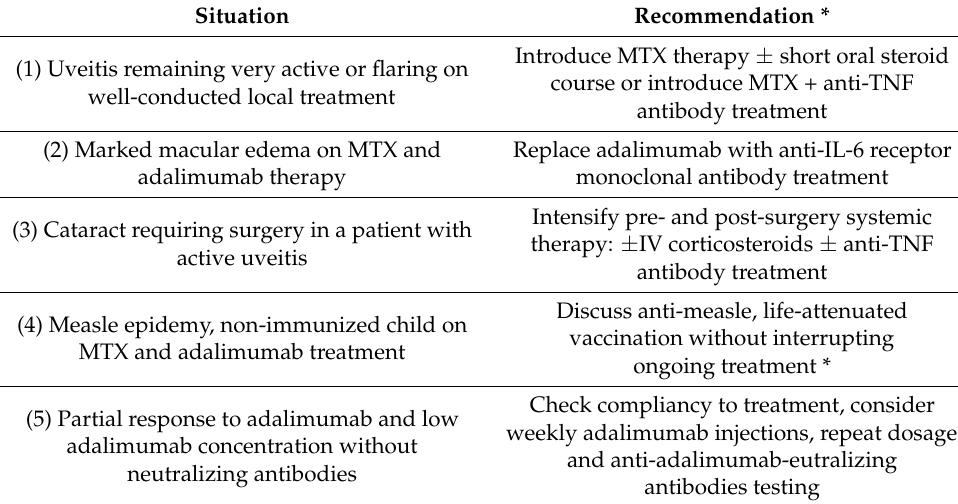
Table 2. Chronic, non-infectious uveitis: some peculiar